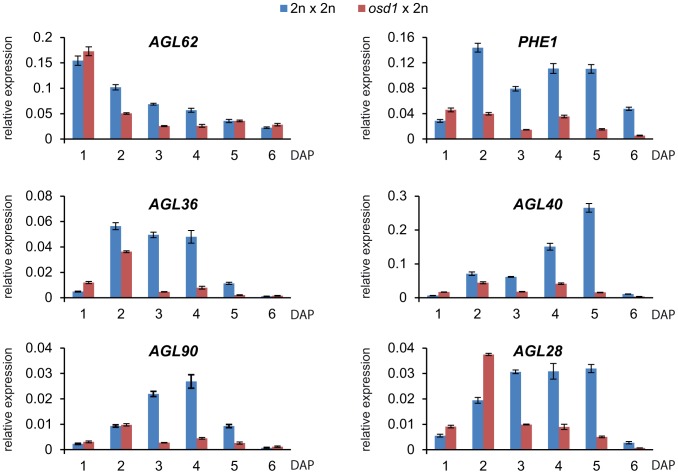
Expression of AGL MADS Box Genes Is Decreased in osd1×2n Crosses.Quantitative RT-PCR analysis of AGL62, PHE1, AGL90, AGL36, AGL40 and AGL28. Error bars indicate s.e.m.